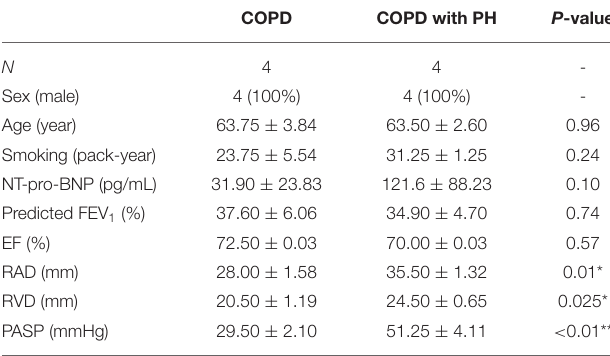
TABLE 1 | Clinical characteristics of participants for antibody